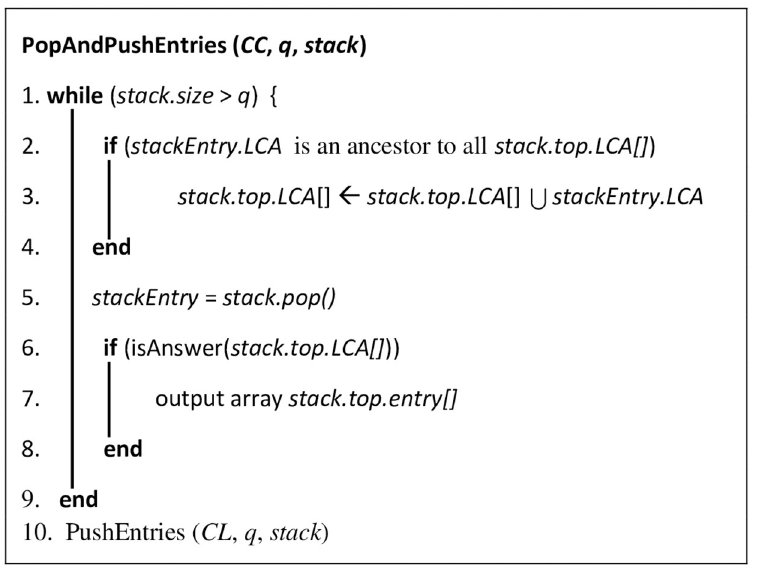
Fig 16. Subroutine PopAndPushEntries.